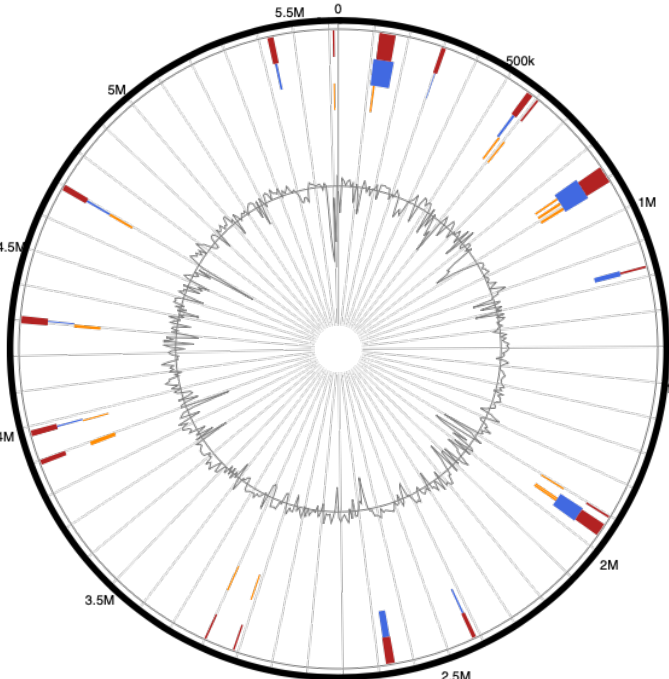
Figure 4. Circular map of the Pseudomonas putida TT322 genome. Genome islands (GIs) are highlighted by color within the circular map for prediction methods. Orange and blue were predicted by SIGI-HMM and IslandPath-DIMOB, respectively. Red regions were predicted GIs by at least one method (integrated GIs). GC contents (%) of the genomic sequence are shown by the black line plot.